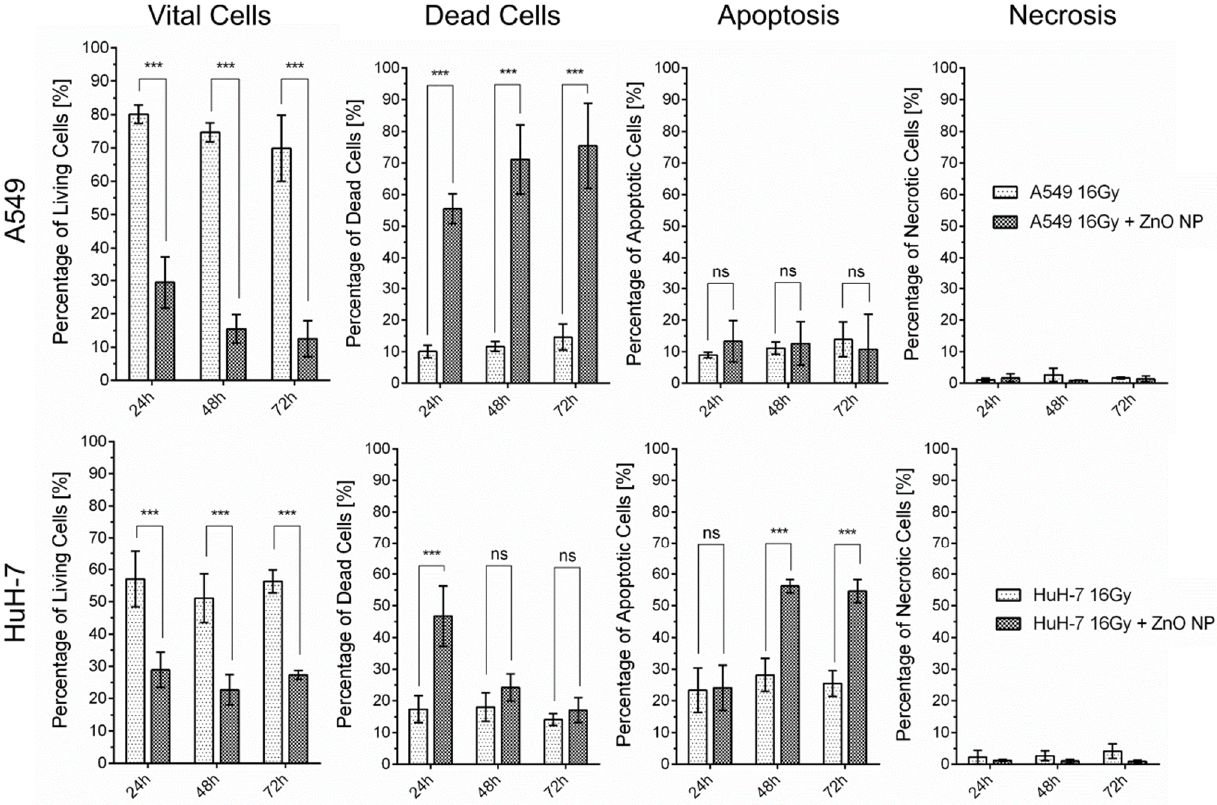
Figure 13. Treatment of senescent A549 and HuH-7 cells with zinc oxide nanoparticles increased the percentage of dead cells significantly and decreased the percentage of vital cells significantly within 24 h as measured by flow cytometry. Shown are mean values ± SD. Two-way ANOVA, comparison of senescent cells and senescent cells treated with 100 µg/mL ZnO NPs of the respective cell line at the indicated time-point post-treatment. Correction for multiple comparisons by Bonferroni, N ≥ 3, *** p < 0.001, ns = not significant.